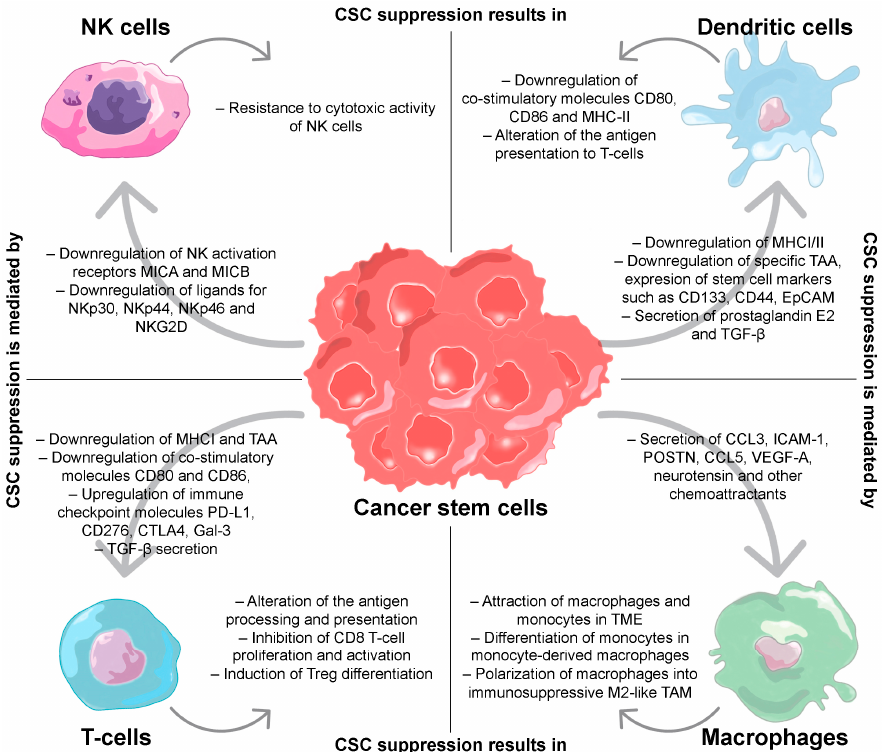
Figure 1. The influence of CSCs on the cells of the immune system is mediated by low immunogenicity of cancer stem cells (reduced expression of MHC-I/II, altered antigen processing and presentation, downregulation of TAA), suppression of the activation of effector T-cells and NK cells due to receptors located on the cancer stem cell surface, as well as secreted factors.